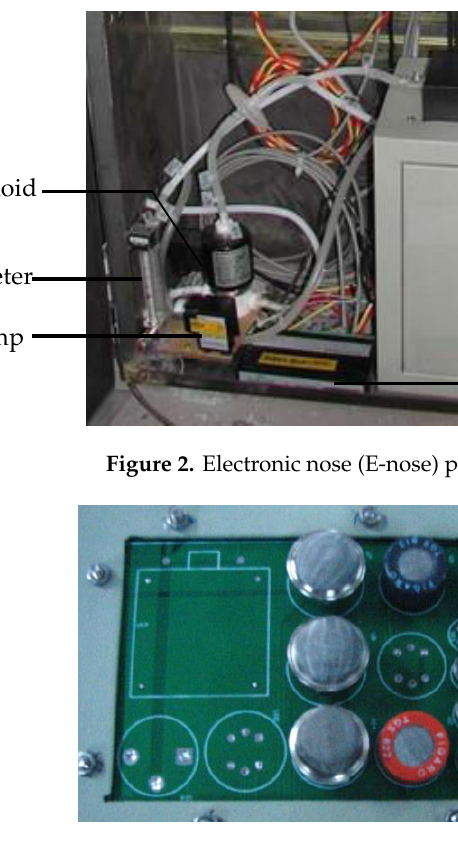
Figure 3. The sensors array in the chamber of E-nose.